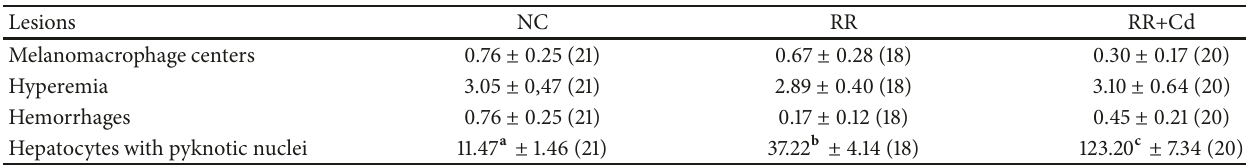
Figure 2: Hematoxylin-eosin stained cross-sections of the mid-section of Cnesterodon decemmaculatus exposed to different treatments for 96 h. Treatments: NC (negative control, MHW); RR (surface water of the Reconquista River); RR+Cd (surface water of the Reconquista River with 2 mg Cd/L). (a) Fish exposed to NC (5X): liver (L); intestine(I); kidney (K); epiaxial muscle(EM); and spine (S). (b) Liver of fish exposed toNC (40X): normal hepatocytes(hp) with onenucleus(n) each. (c)Liver of fish exposed to RR (40X):hepatic vein (hv)and hepatocyteswith pyknotic nuclei (pn) in the parenchyma and thin sinusoids in the parenchyma. (d) Liver of fish exposed to RR+Cd (40X): marked increase in the number of hepatocytes with pyknotic nuclei (pn). Table 2: Quantification of liver damage: values of the lesions induced by the different treatments. Data are expressed as mean ± SEM. Treatments: NC (negative control, MHW); RR (surface water of the Reconquista River); RR+Cd (surface water of the Reconquista River with 2 mg